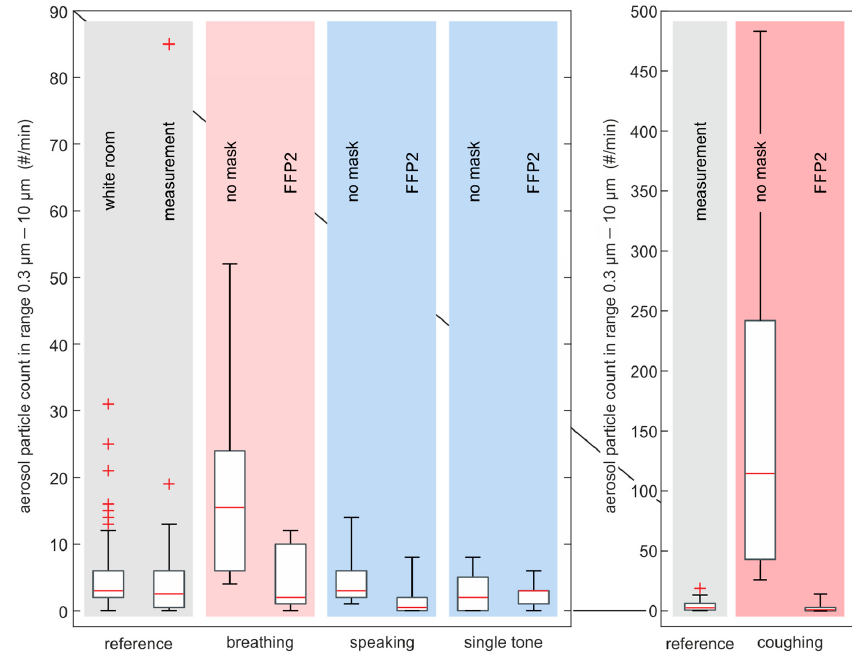
Figure 6. Boxplots of all aerosol particle measurement tasks performed in an OR. Y -axis shows the accumulated aerosol particle count in the range from 0.3 µm to 10 µm and x -axis shows the performed task. For better visualization, the diagram is divided into two plots with different y -axis limits. Note that the measurement references in both plots are the same. We use boxplots without outliers to show the data of the RAs, due to the small sample size of n = 6. The reference data sets are shown by boxplots with outliers (+), since they consist of larger data sets (540/24 measurements).